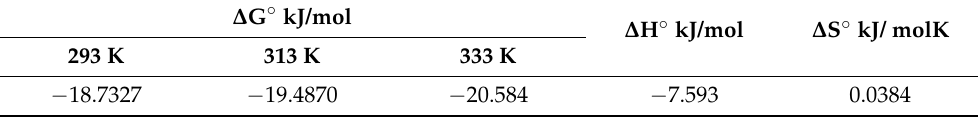
Table 4. Thermodynamic parameters for adsorption of AO-8 on Pd-Ni/AC-CeO 2